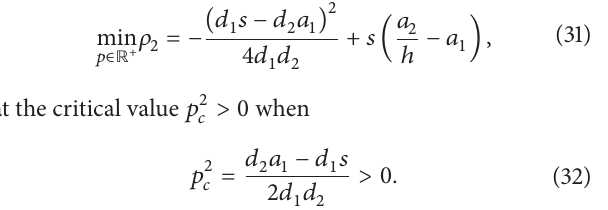
Figure 2: Phase portraits of model (1). The parameters are taken as 𝑟 = 1 , 𝑚 = 1 , 𝑎 = 0.4 , 𝐾 = 4 , ℎ = 0.7 , 𝑐 = 0.8 , 𝑠 = 0.4912764003 . Model (1) enters into Hopf bifurcation around 𝐸 ∗ = (0.21053, 0.30075) , and there is a limit cycle. The dashed curve is the 𝑢 -nullcline, and the dotted vertical line is the V